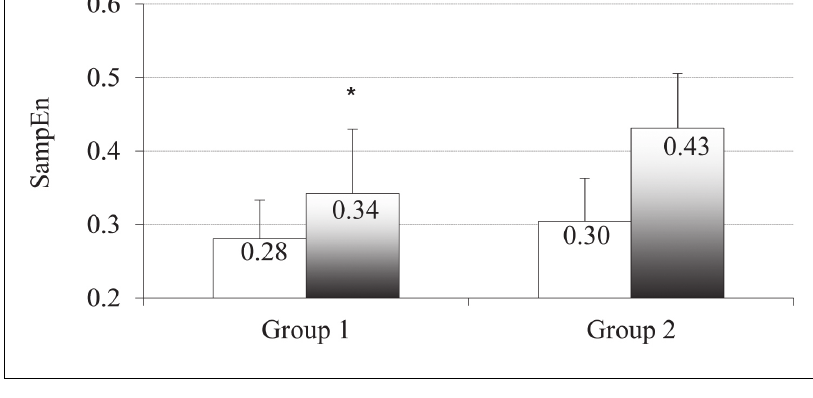
Figure 1. Mean values (mm/s) of changes in COP in the lateral (COP dx) and anterior-posterior (COP dy) directions